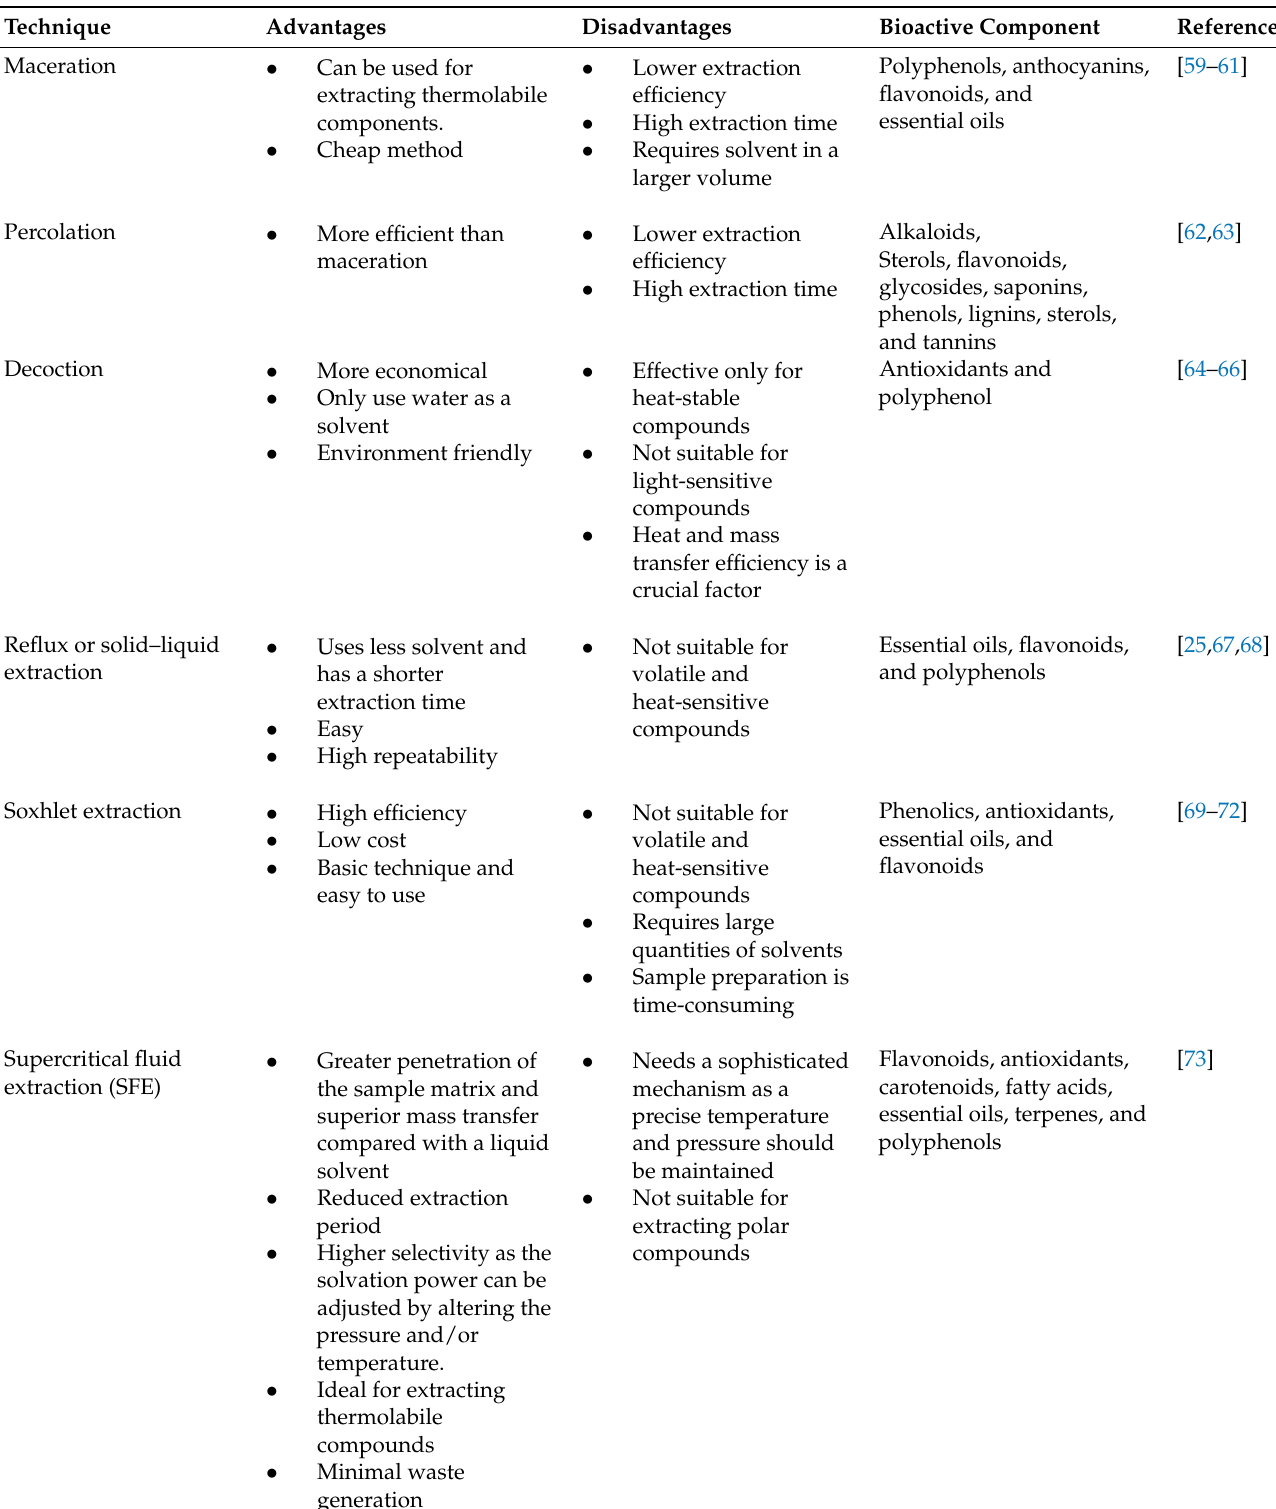
Table 1. Techniques for the extraction of bioactive